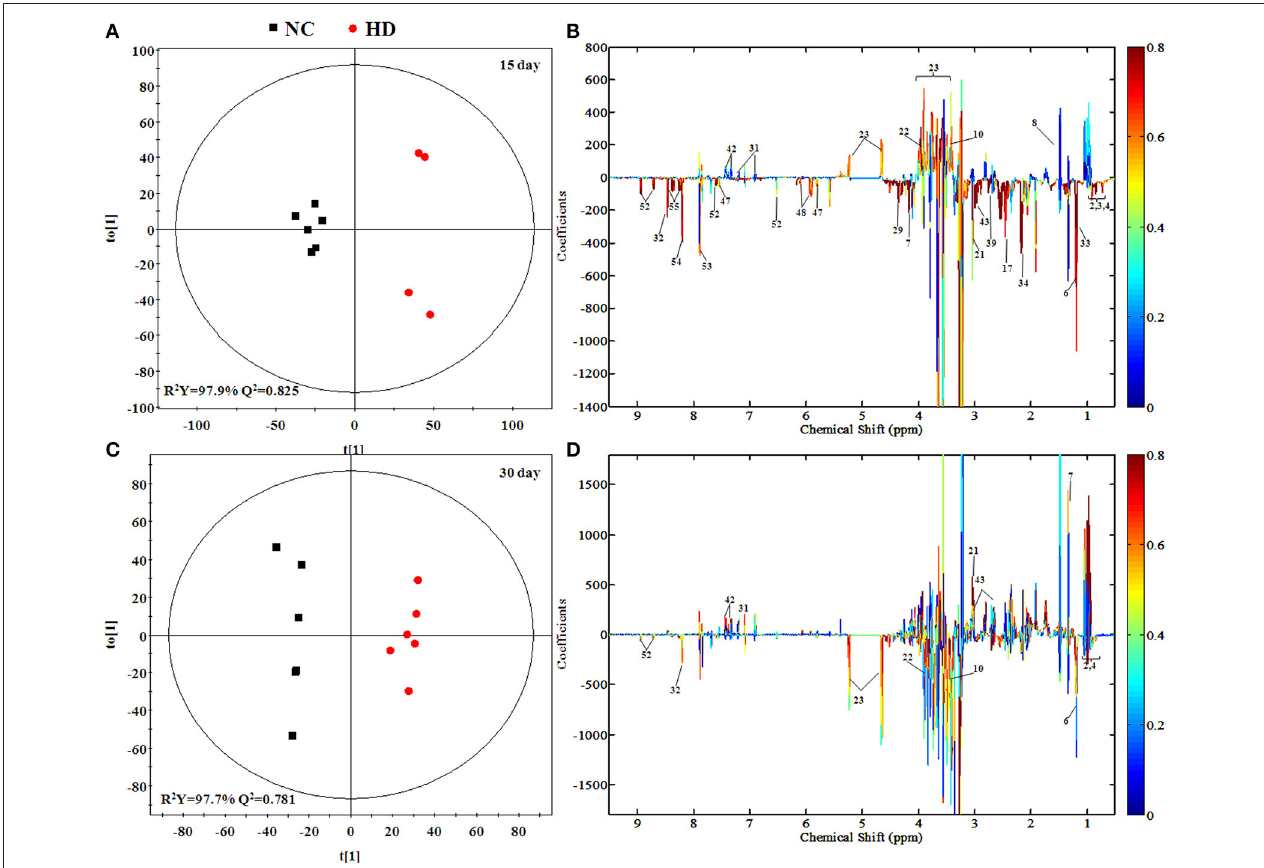
FIGURE 5 | OPLS-DA scores plots (A,C) and coefficient loading plots (B,D) derived from 1 H NMR spectra of liver extract from HD and NC group at day 15 and day 30. The color code corresponds to the correlation coefficients of the metabolic variables. The loading plots identifying discriminatory metabolites between HD and NC group are based on the first principal component [ t (1) ]. Signals with a positive direction relate to the abundance of metabolites in the groups in the positive direction of [ t (1) ], and vice